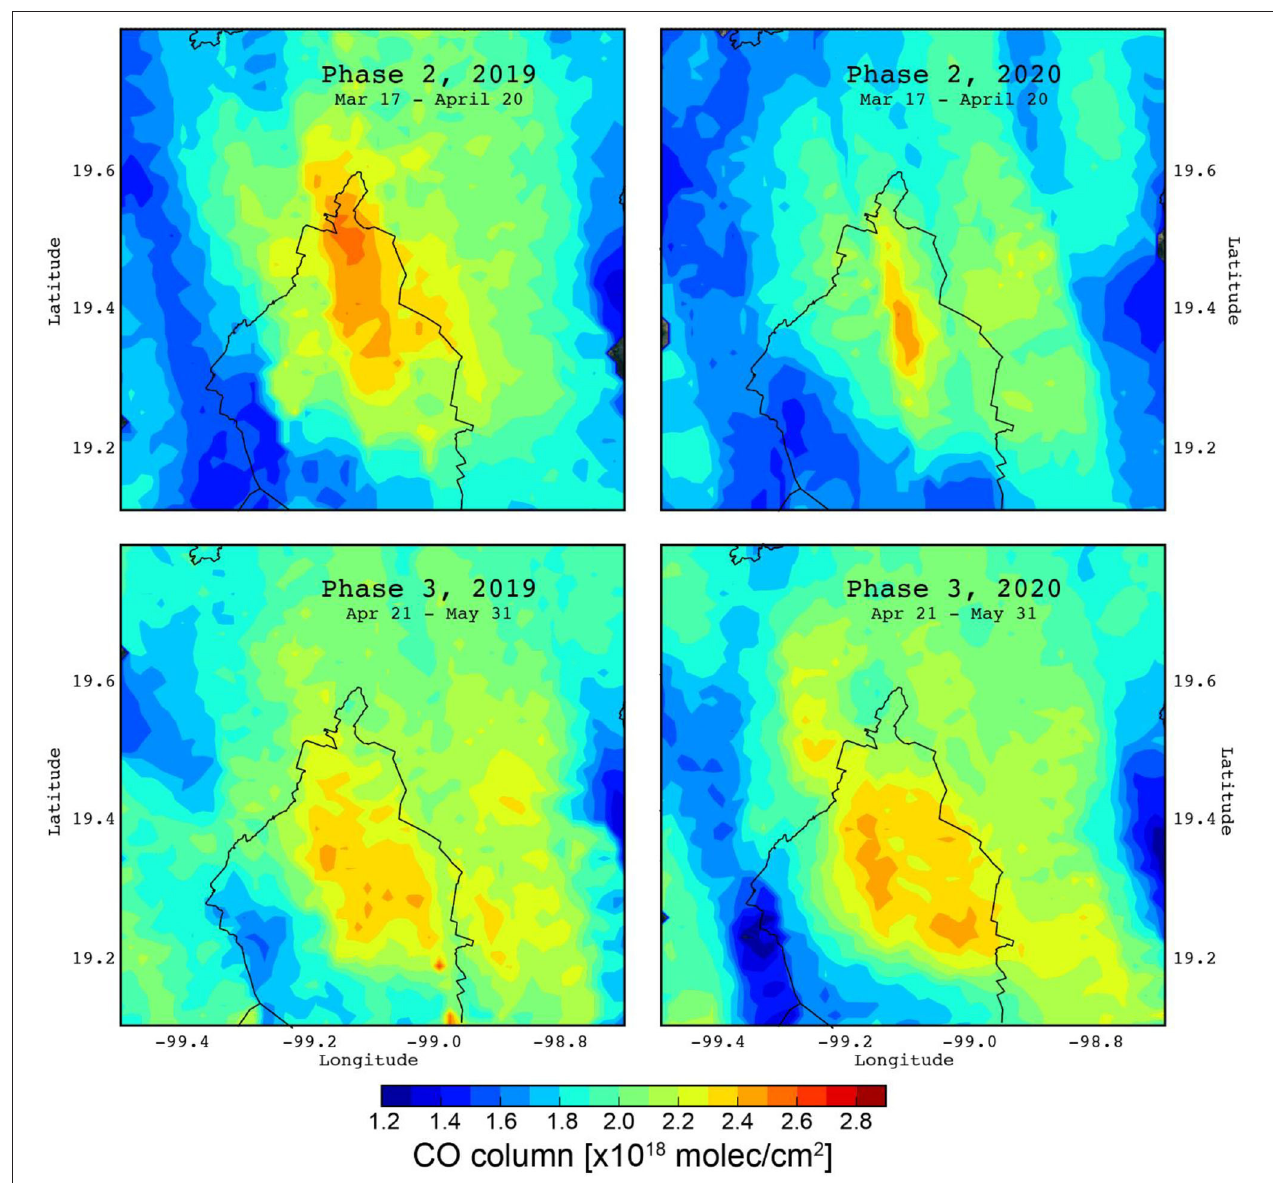
FIGURE 8 | Averaged CO column distribution maps constructed from satellite-based data from TROPOMI over the MCMA during lockdown Phases 2–3 of 2020 (right) with respect to the previous year